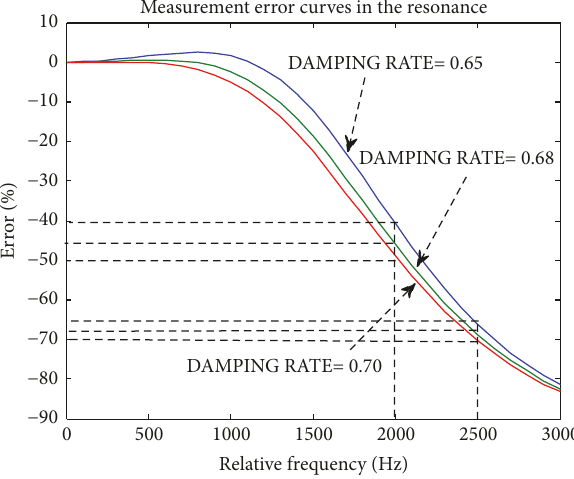
Figure 7: Measurement error as a function of relative frequency for three values of damping rate in the case where the relative frequency is varied from 0 to